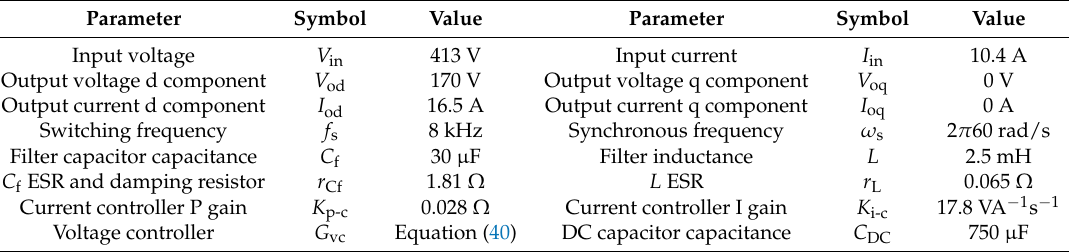
Figure 8. Block diagram of the laboratory setup. Table 2. Experimental grid-forming inverter parameters and operating point